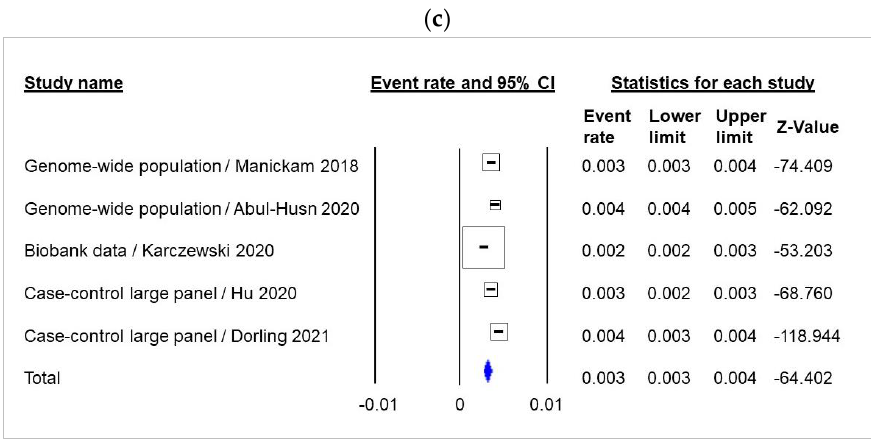
Figure 3. Meta-analysis of gBRCA1 and gBRCA2 carriers among 238,972 unaffected individuals. ( a )